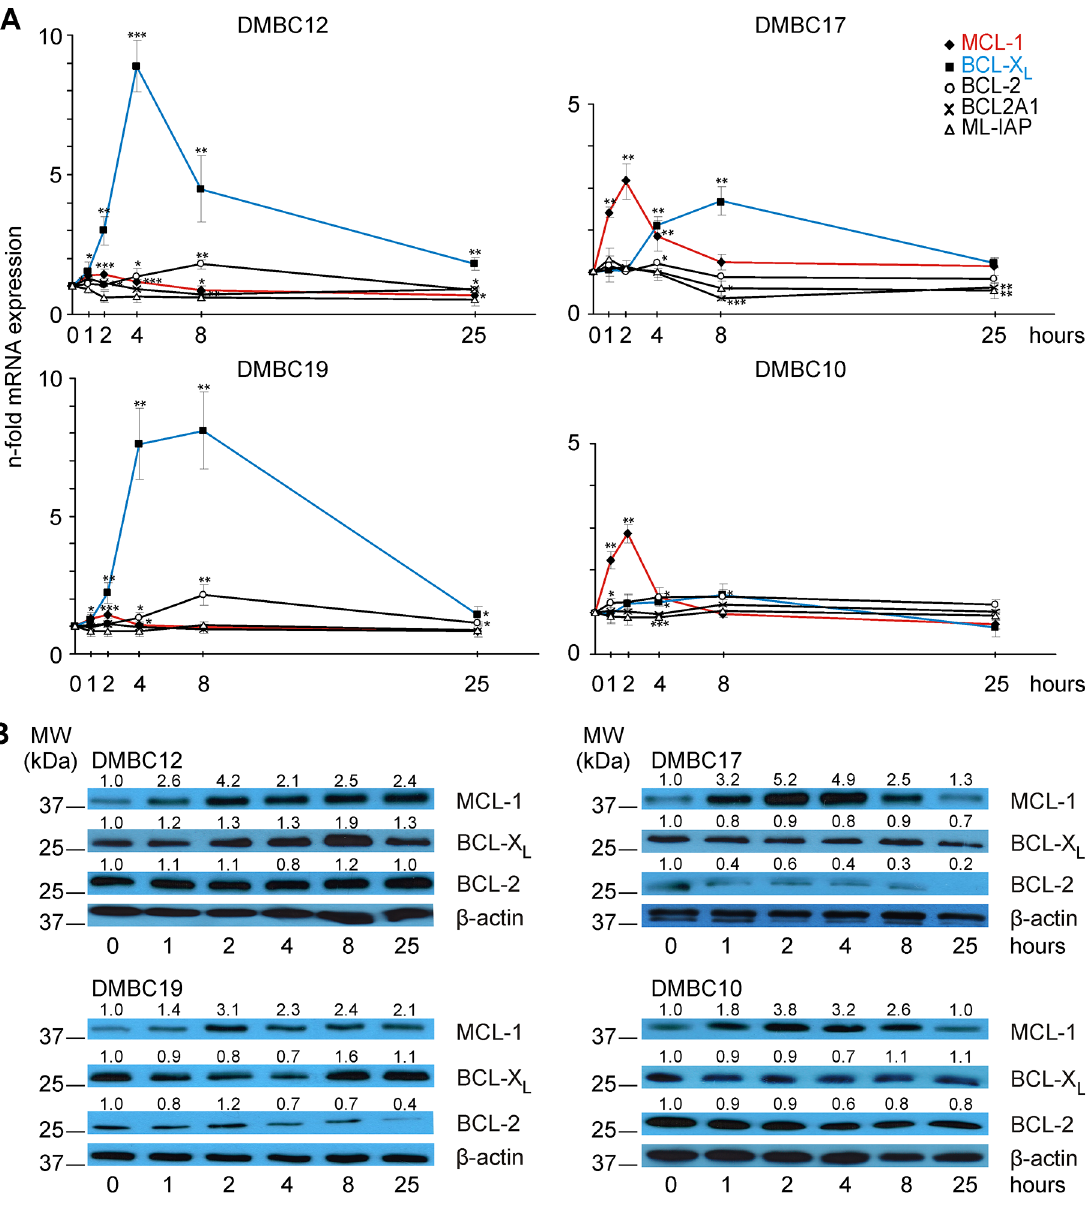
Fig 3. Melanoma cells grown in EGF(+)bFGF(+) medium respond to changes in microenvironment by employing pro-survival machinery. (A) DMBC12, DMBC19, DMBC17 and DMBC10 populations grown in EGF(+)bFGF(+) medium were dissociated and one day later (0 h) they were exposed to serum-containing medium. qRT-PCR was used to analyze the mRNA levels of pro-survival genes at indicated time points of medium exchange. Data are presented as the means ± SD from three independent experiments. * p < 0.05; ** p < 0.01; *** p < 0.001. For clarity, *** ( p < 0.001) for MCL-1 in DMBC12 cells after 1 h was not indicated. (B) Cell lysates were prepared at indicated time points after transfer to serum-containing medium, and pro-survival proteins MCL- 1, BCL-X L and BCL-2 were immunoblotted (n = 3). Localization and molecular weight (MW) of marker bands are indicated. β -actin was used as a loading control. Quantification of protein level is shown above the